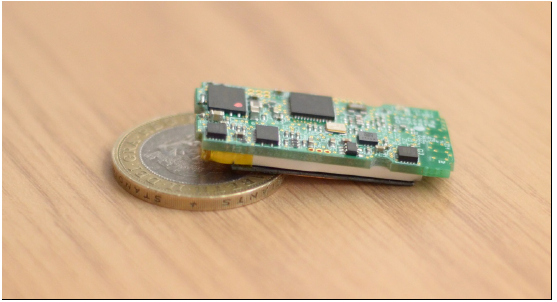
Figure 1. SPW-2: The Second SPHERE